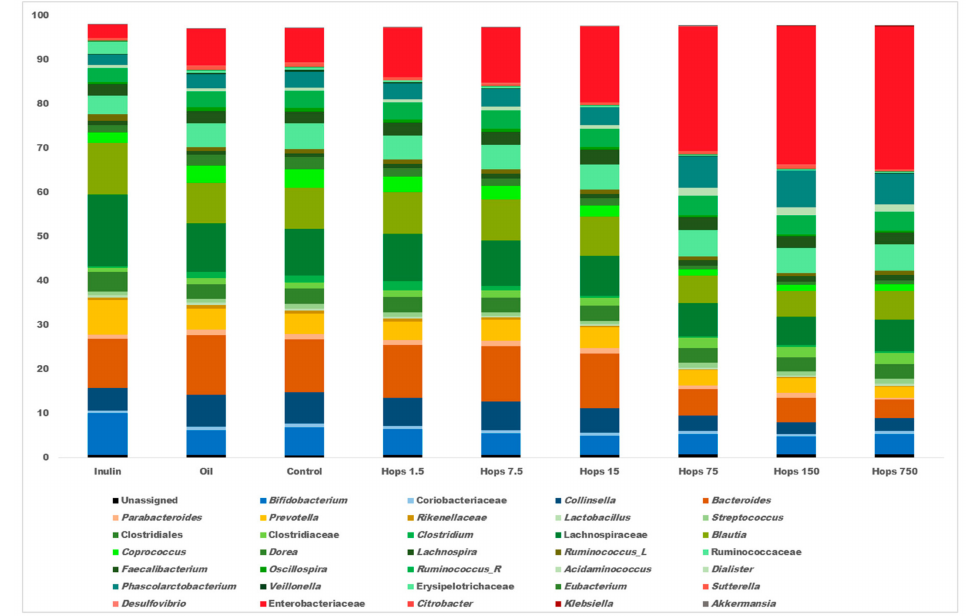
Figure 2. Average ( n = 3) relative abundance of bacterial taxa in each separate fermentation (all time points). Only genera present at greater than 0.5% relative abundance in at least one sample are displayed. Genera bar colors correspond to the phyla they belong to—Actinobacteria, blue; Bacteroidetes, orange; Firmicutes, green; Proteobacteria, red; Verrucomicrobia, grey. Ruminococcus _R, Ruminococcaceae family; Ruminococcus_ L, Lachnospiraceae